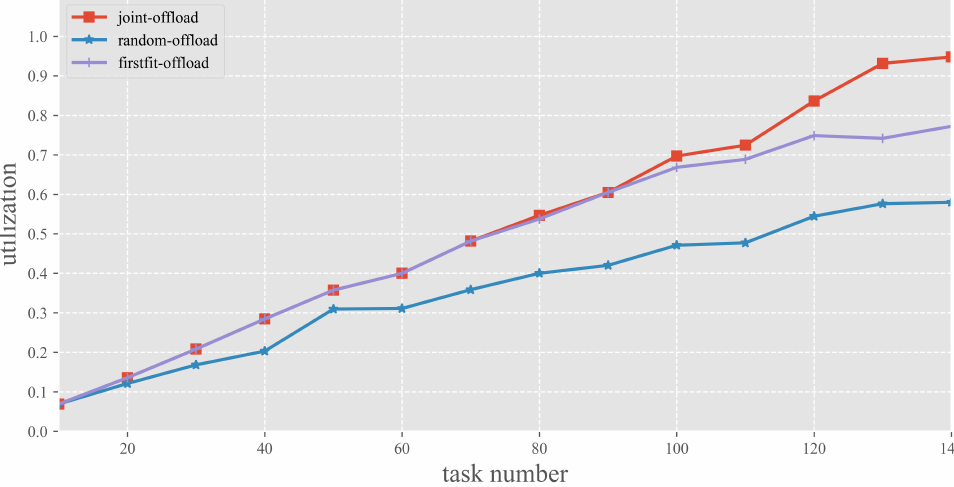
Figure 11. Satellite computing resource utilization of the three offloading strategies varies with the number of tasks in the whole constellation offloading scenario.